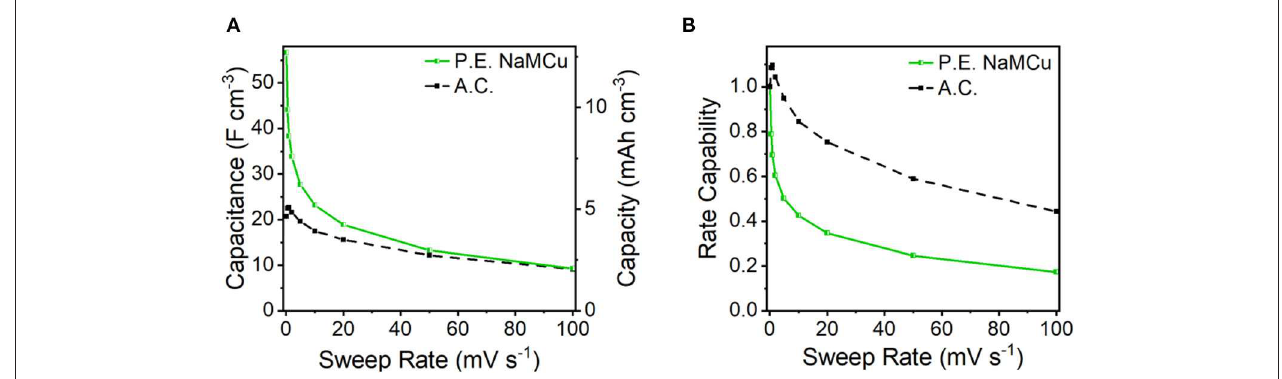
FIGURE 9 | (A) Volumetric capacity/capacitance and (B) rate capability of P.E. NaMCu and activated carbon (A.C.)